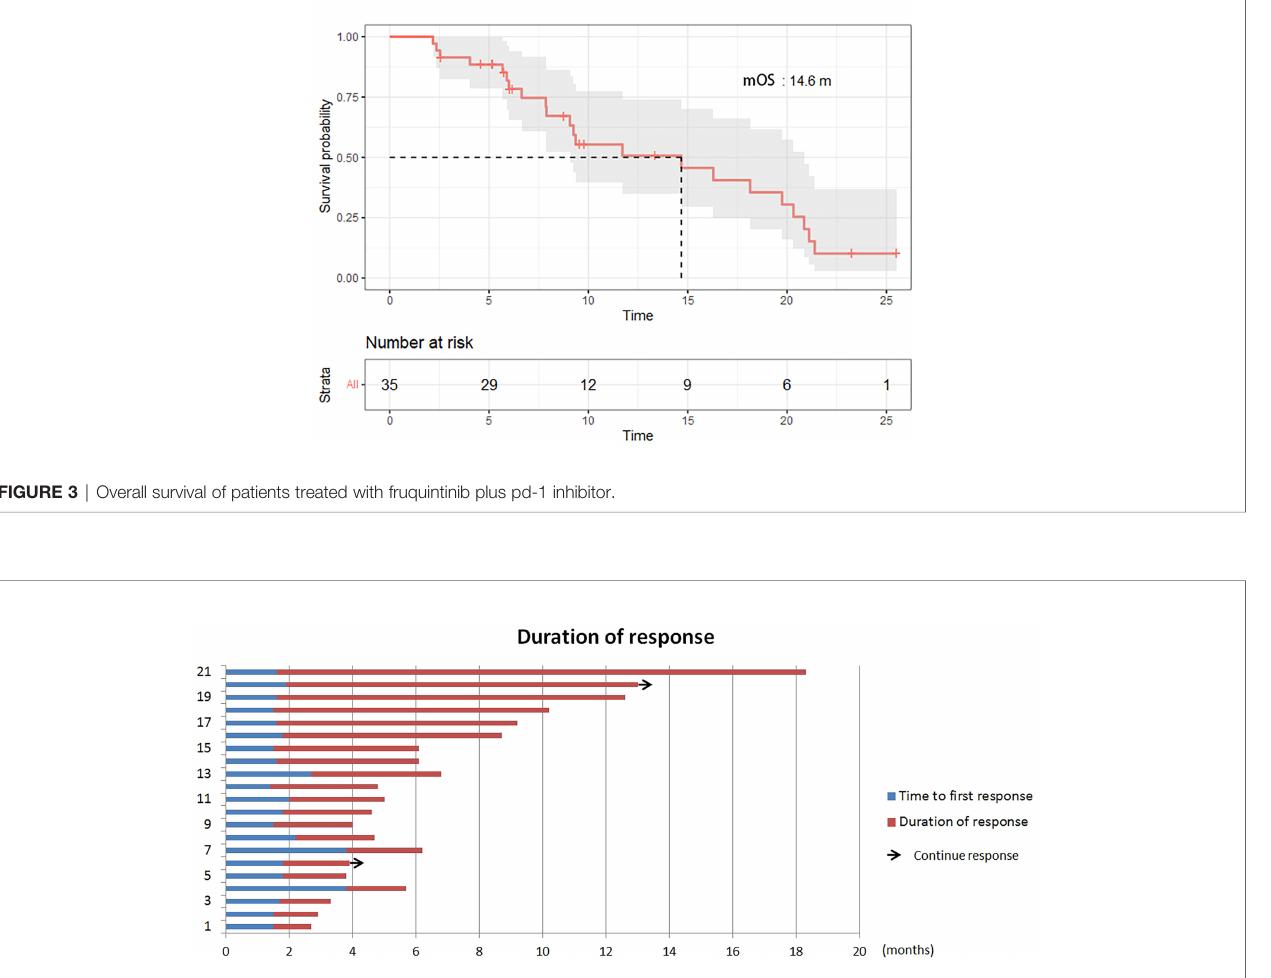
FIGURE 4 | Duration of time of patients treated with fruquintinib plus pd-1